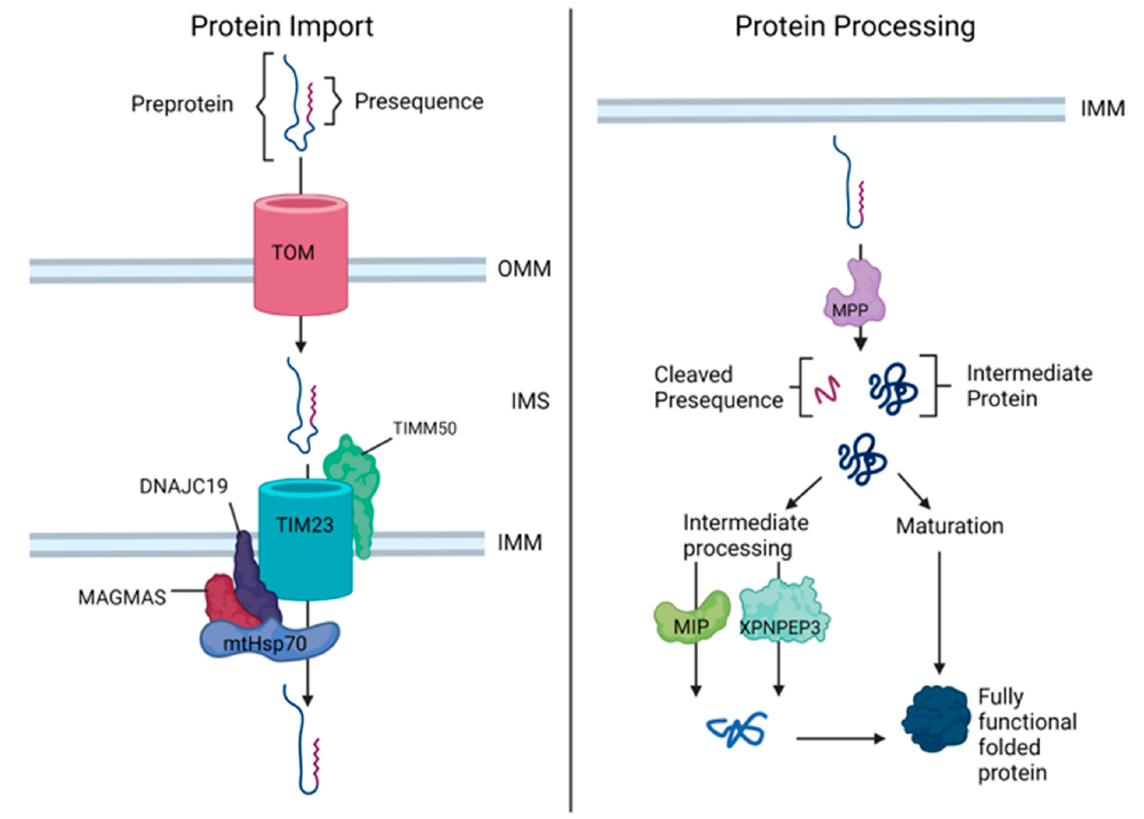
Figure 1 . Proteins involved in mitochondrial protein homeostasis and associated with human car- diomyopathy. The translocase of the inner mitochondrial membrane (TIM23) is comprised of the translocase of the inner mitochondrial membrane 50 (TIMM50), mitochondrial import inner mem- brane translocase subunit TIM16 (MAGMAS), mitochondrial heat shock protein 70 (mtHsp70), and DnaJ heat shock protein family (Hsp40) member C19 (DNAJC19). Formation of the TIM23 complex pulls presequence proteins into the mitochondrial matrix. Mitochondrial processing peptidase (MPP), mitochondrial intermediate peptidase (MIP), and X-Pro aminopeptidase 3 (XNPEP3) per-